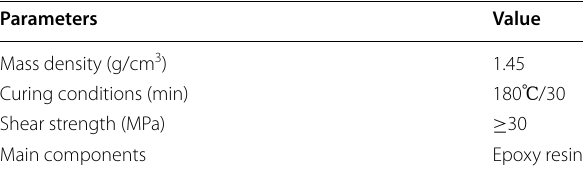
Table 1 Main performance parameters of the hemming